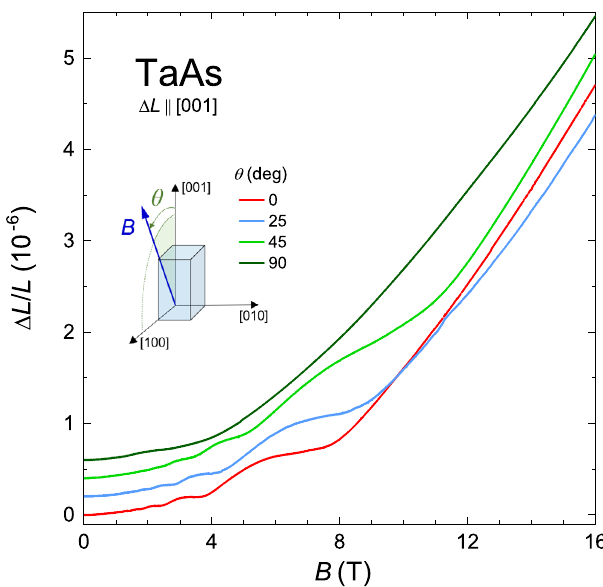
Fig. 7 Angle-dependent magnetostriction of TaAs measured along the c axis. Field-induced relative length change of TaAs (sample 3) along the [001] direction is measured at T = 4.2 K and at various angles θ between the direction of B and the c axis. The magnetic fi eld lies in the plane (010). For clarity, the different Δ L / L curves at θ > 0 were shifted subsequently by 0.2 × 10 − 6